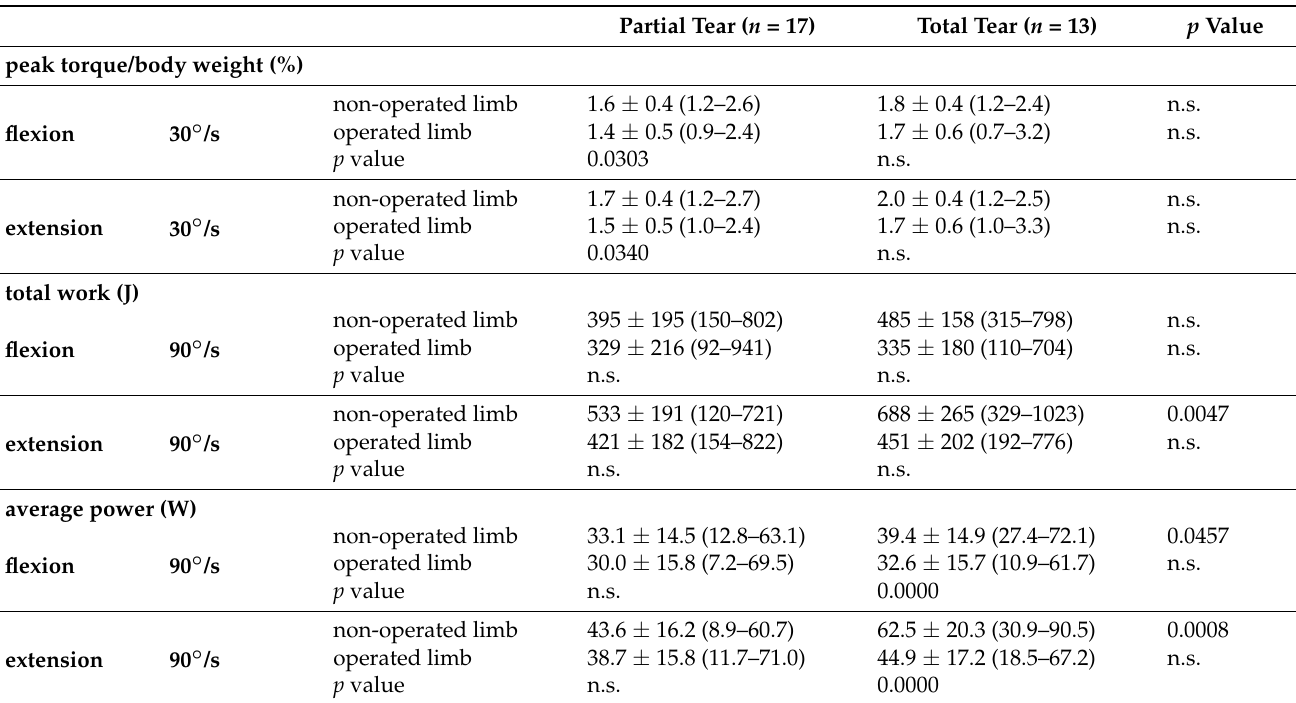
Table 7. The comparison of the isokinetic outcomes of the surgical procedure between two Achilles tear